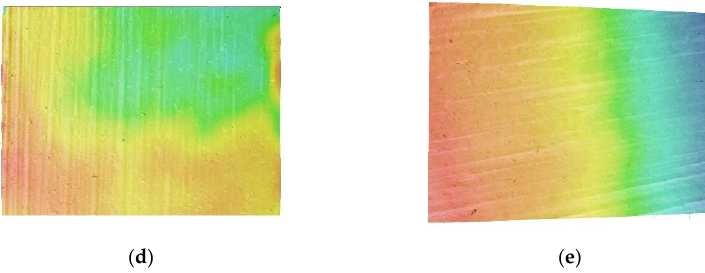
Figure 22. The surface appearance of five regions after 1 h processing: ( a ) L1, ( b ) L2, ( c ) L3, ( d ) L4, ( e ) L5.